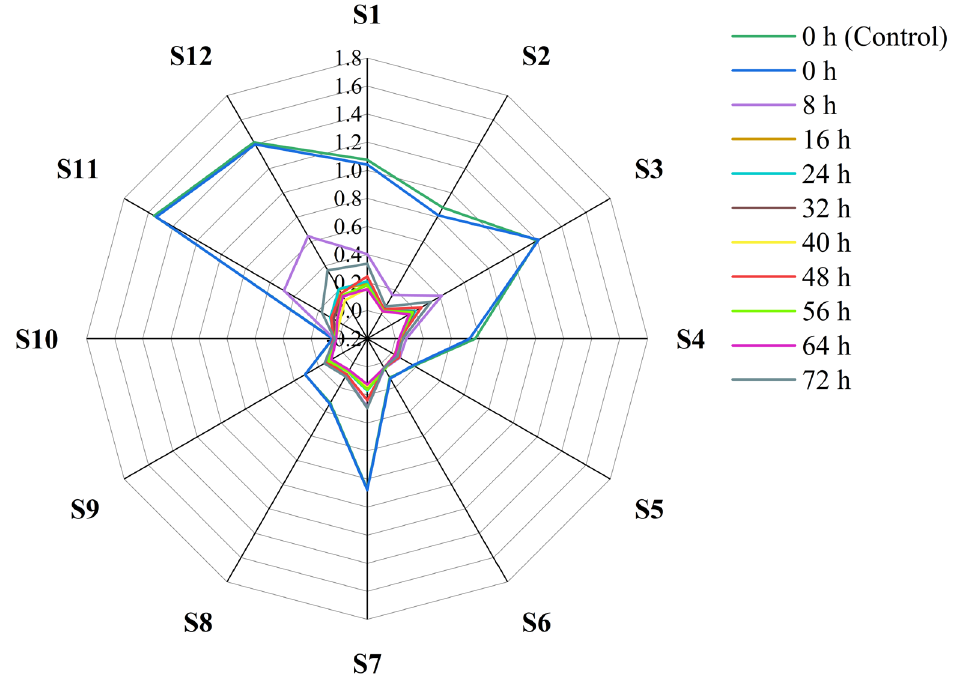
Figure 6. Response of 12 sensors to volatile compounds in sweetpotatoes.